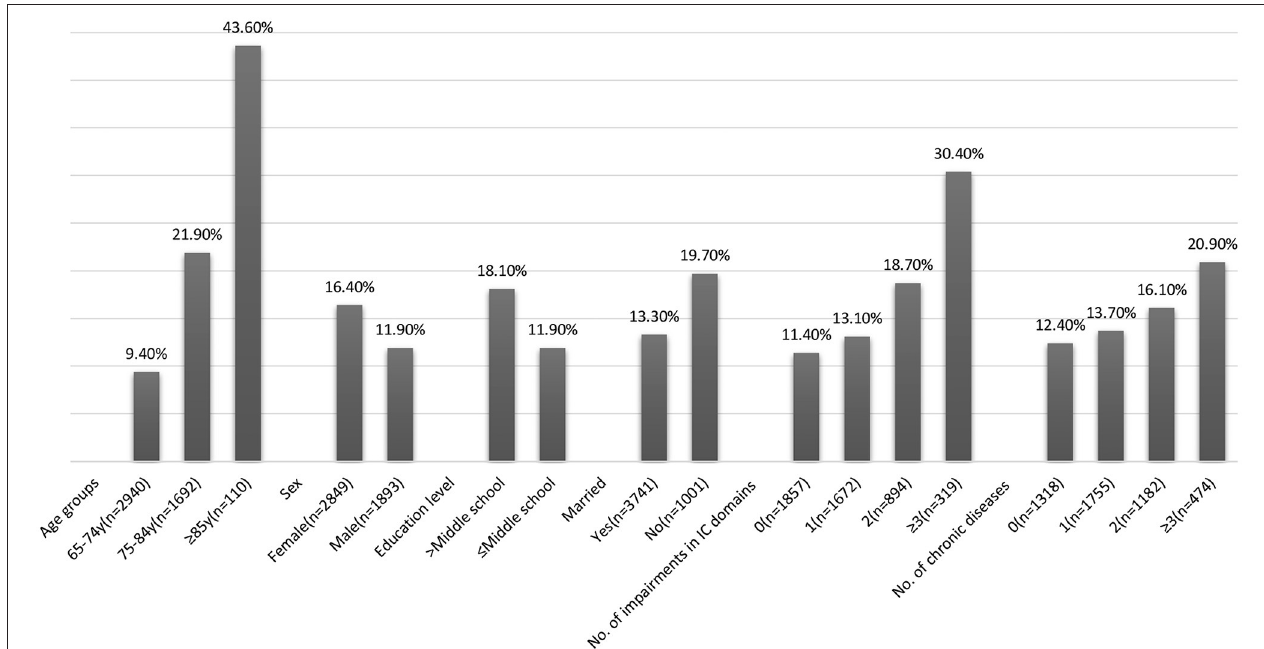
FIGURE 3 | Incidence of activities of daily living (ADL) disability at 1-year